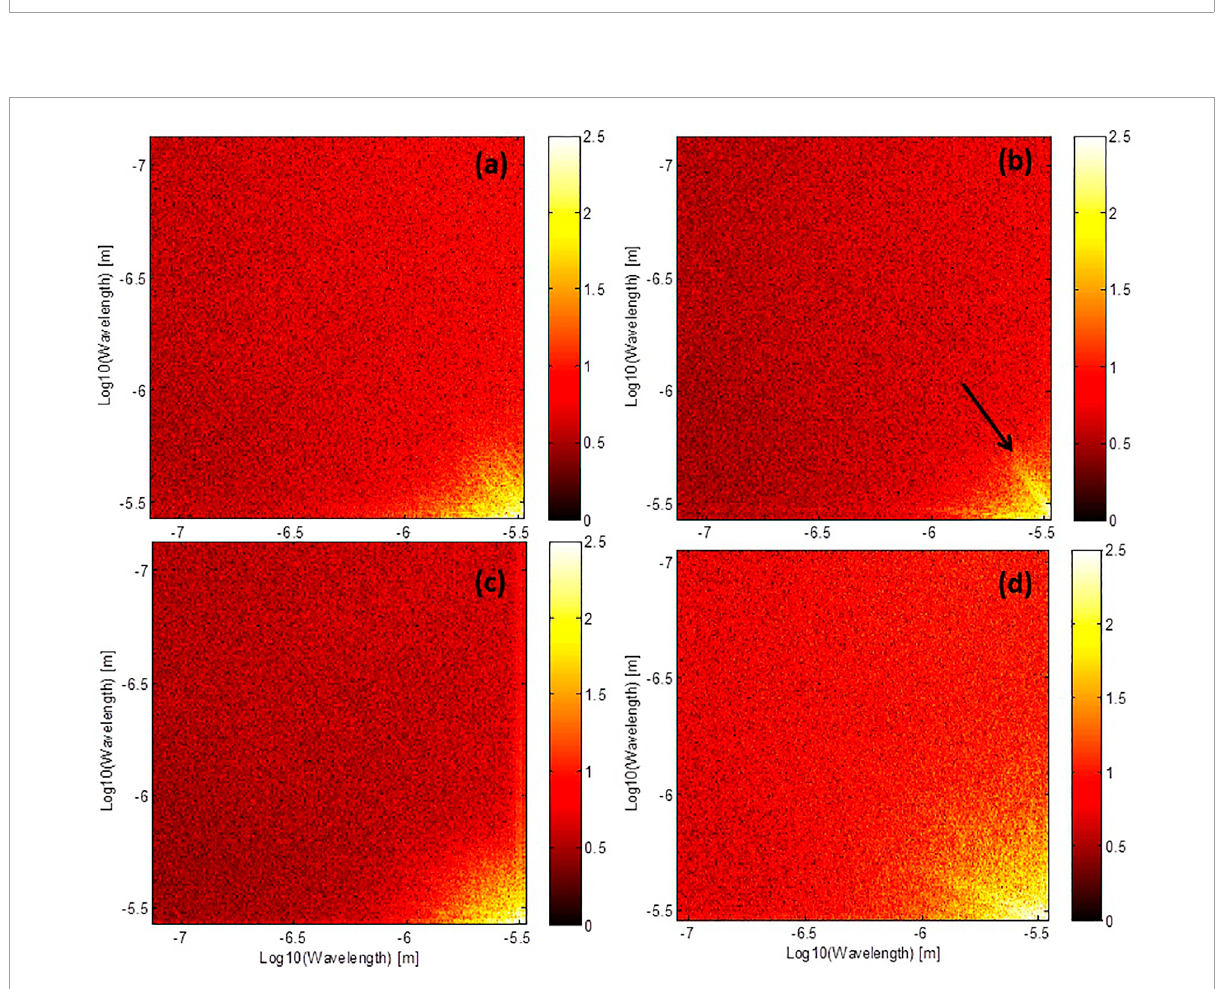
FIGURE 8 FFT bidimensional spectra, Log 10 λ y vs. Log 10 λ x (with λ in [m]), measured for (A) untreated, (B) sprayed, (C) plasma-treated and subsequently sprayed, and (D) plasma-treated-only samples. In all cases, at sub-micrometer scales, λ < 3 μ m. The arrow indicates a direction of higher